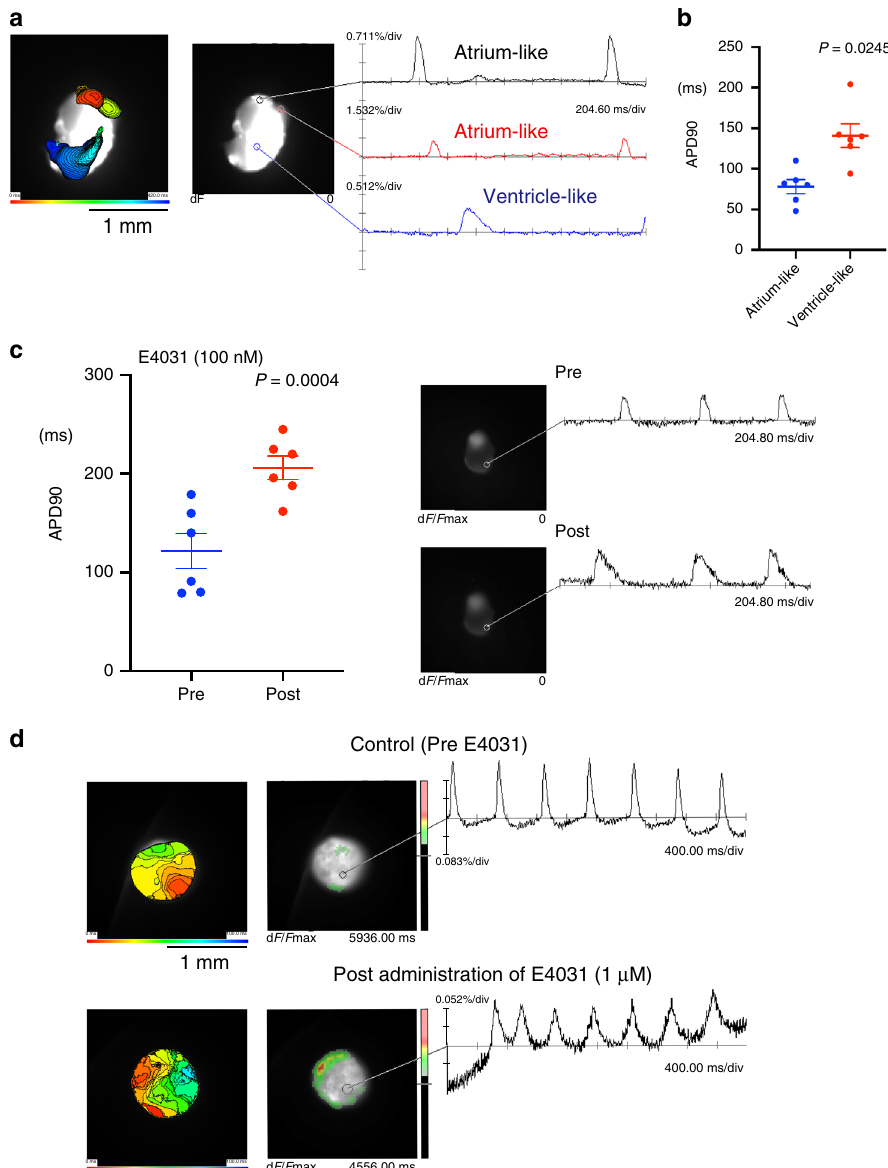
Fig. 10 Electrophysiological properties of heart organoid (HO)s. a Activation map during spontaneous excitation (left). Each local action potential of atrium-like (black and red) and ventricle-like (blue) components was presented in diagrams (right). b Action potential duration (APD90) in each atrium- and ventricle-like action potential of HOs ( n = 6, P = 0.0245 by two-sided paired t test). Data are presented as mean values ± SEM. c APD90 of HOs was analyzed by optical mapping in HOs pre- and post treatment with 100 nM of E4031 (left, n = 6, P = 0.0004 by two-sided paired t test). Data are presented as mean values ± SEM. The representative optical mapping data of HOs pre- and post treatment with 100 nM of E4031 (right). d Action potentials recorded by optical mapping in HOs, pre- (top) and post (bottom) treatment with the IKr blocker E4031 (1 μ M). High-resolution activation maps (left panels) show that the excitation pattern and excitation propagation speed are different in HOs before and after treatment with E4031 (right diagrams, see also Supplementary Movie